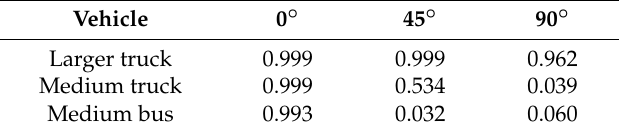
Table 3. The detectability (P d ) of each vehicle at intersection angles of 0 ◦ , 45 ◦ , and 90 ◦ in Experiment I.